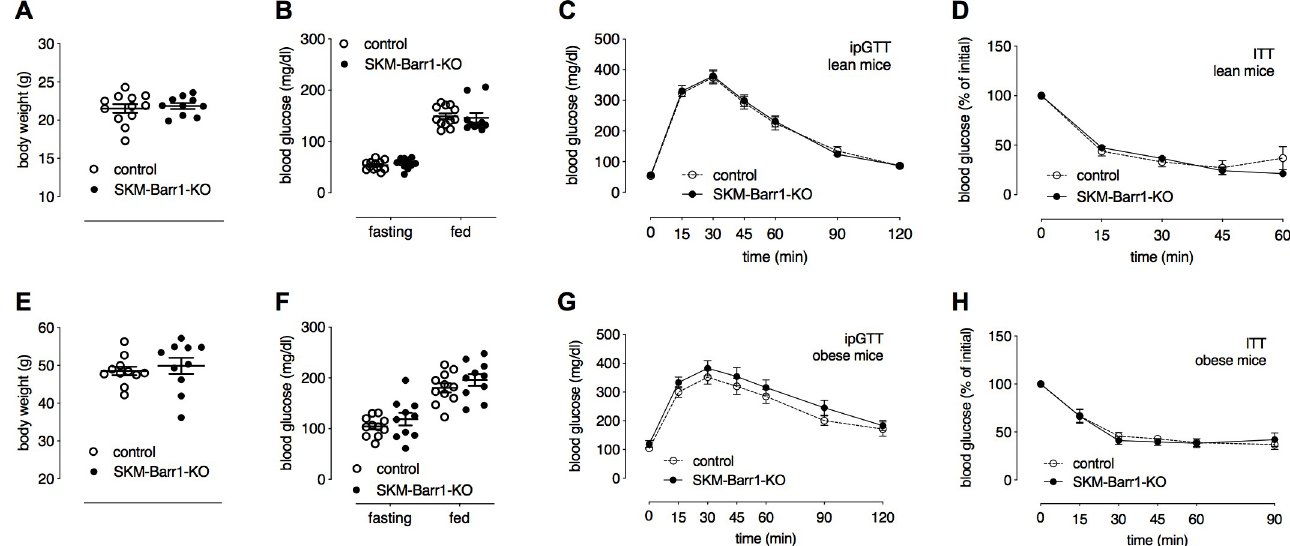
Fig 1. Loss of Barr1 in SKM has no impact on glucose and insulin tolerance in mice. All experiments were carried out with SKM-Barr1-KO mice and their control littermates (adult males) maintained on regular chow (A-D) or a high-fat diet (HFD) for at least 8 weeks (E-H). (A, E) Body weights. (B, F) Fasting and fed blood glucose levels. (C, G) I.p. glucose tolerance test (ipGTT). (D, H) Insulin tolerance test (ITT). Initial blood glucose levels were set to 100% (actual basal blood glucose levels were (in mg/dl): 134 ± 8 vs. 128 ± 6 (D) and 180 ± 9 vs. 196 ± 11 (H) for control vs. SKM-Barr1-KO mice, respectively). Data are shown as mean ± SEM (9–12 mice per